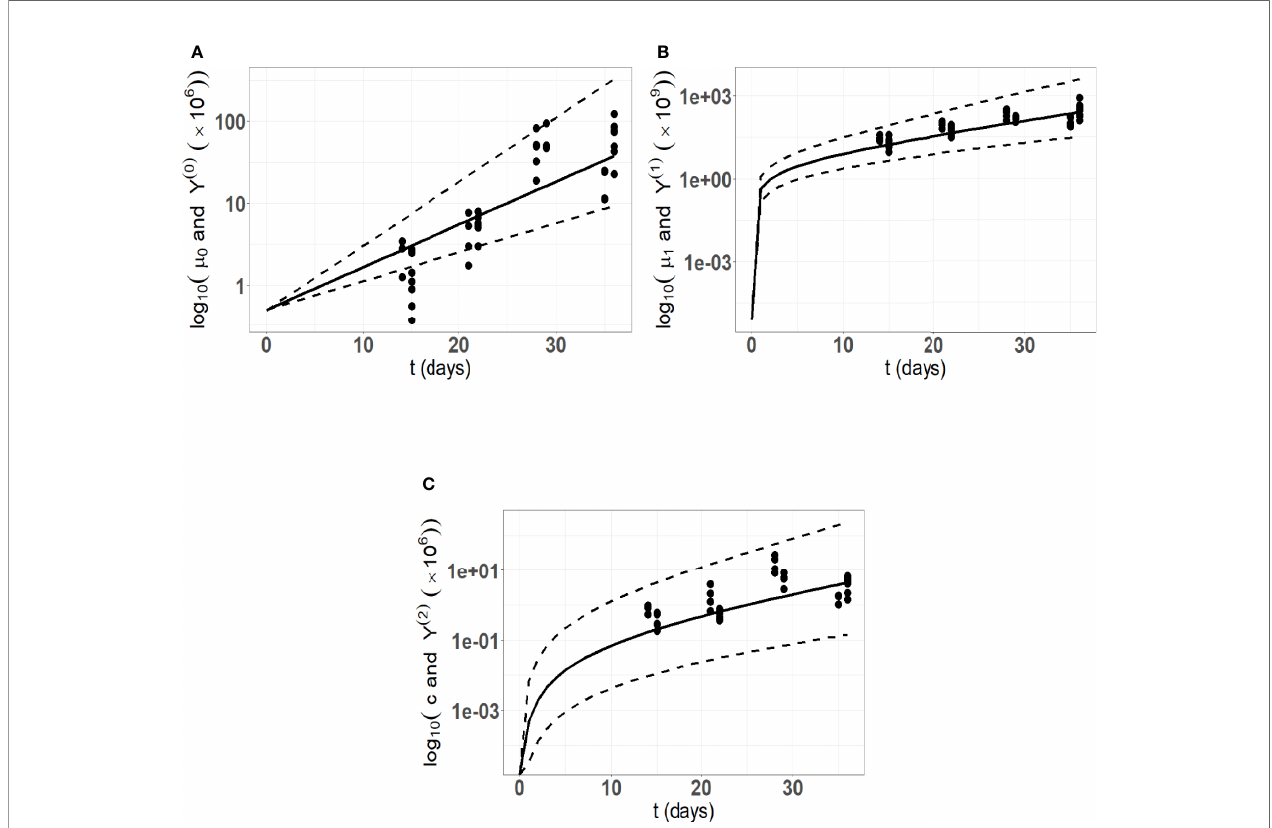
FIGURE 4 | Model fi tting to the in vivo experimental cSCC tumor growth data. Here, we are using 34 data points from an in vivo experimental cutaneous squamous cell carcinoma (cSCC) tumor growth mouse model (59). (A) Number of tumor cells kinetics; (B) Tumor volume kinetics ( m m 3 ); (C) Concentration of immune cells kinetics. The solid lines represent the model prediction using the mean estimated parameters, the dashed lines represent the model predictions using the 5th and 95th percentiles of the parameters distribution.